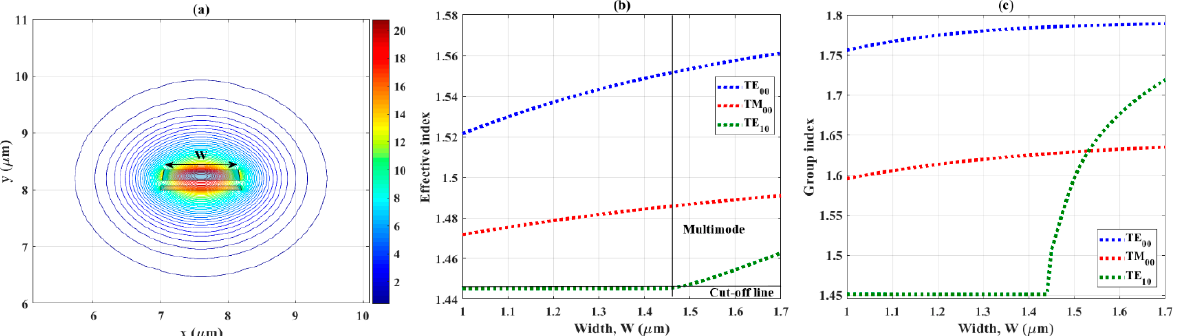
Figure 2. ( a ) Simulated transversal profile of the major electric field component E x of the TE 00 mode of the ADS waveguide, W = 1.1 μ m is the top-width of the top stripe; ( b ) effective index variation, and ( c ) group index variation of first three modes with the width (W) of the waveguide.